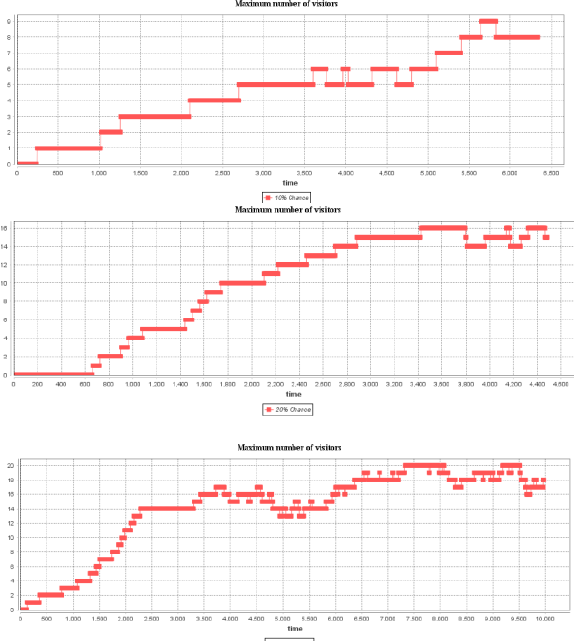
Figure 12. Chart of total visitors for the three chance